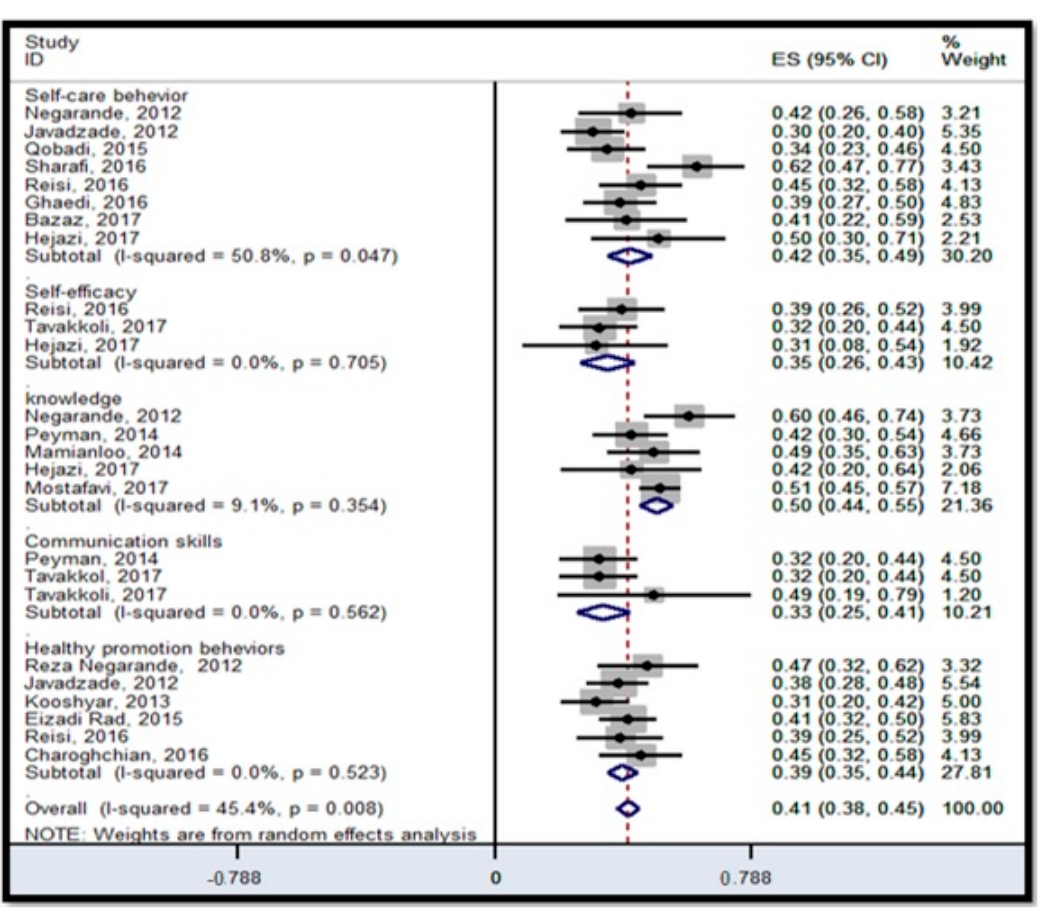
Figure 5. Forest plot for binary outcomes for the association between health literacy, self-care behaviors, self-efficacy, knowledge, communication skills, and health promotion behaviors, ES: effect size, I 2 : a measure of the ratio of the total variation in study measures due to heterogeneity, p > 0.05: devastates heterogeneity is appropriate for interpretation.